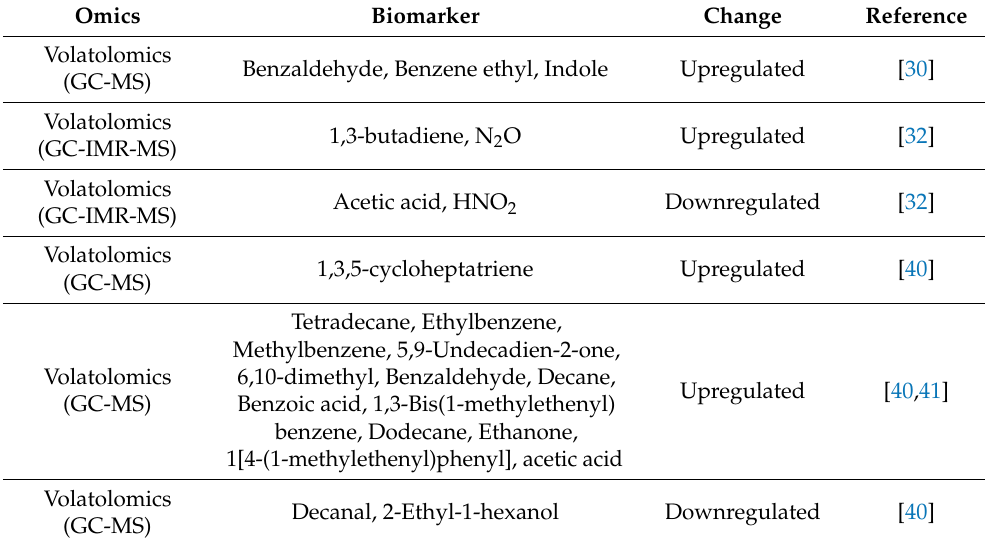
Table 1. Main biomarkers found in breath samples of CRC patients with